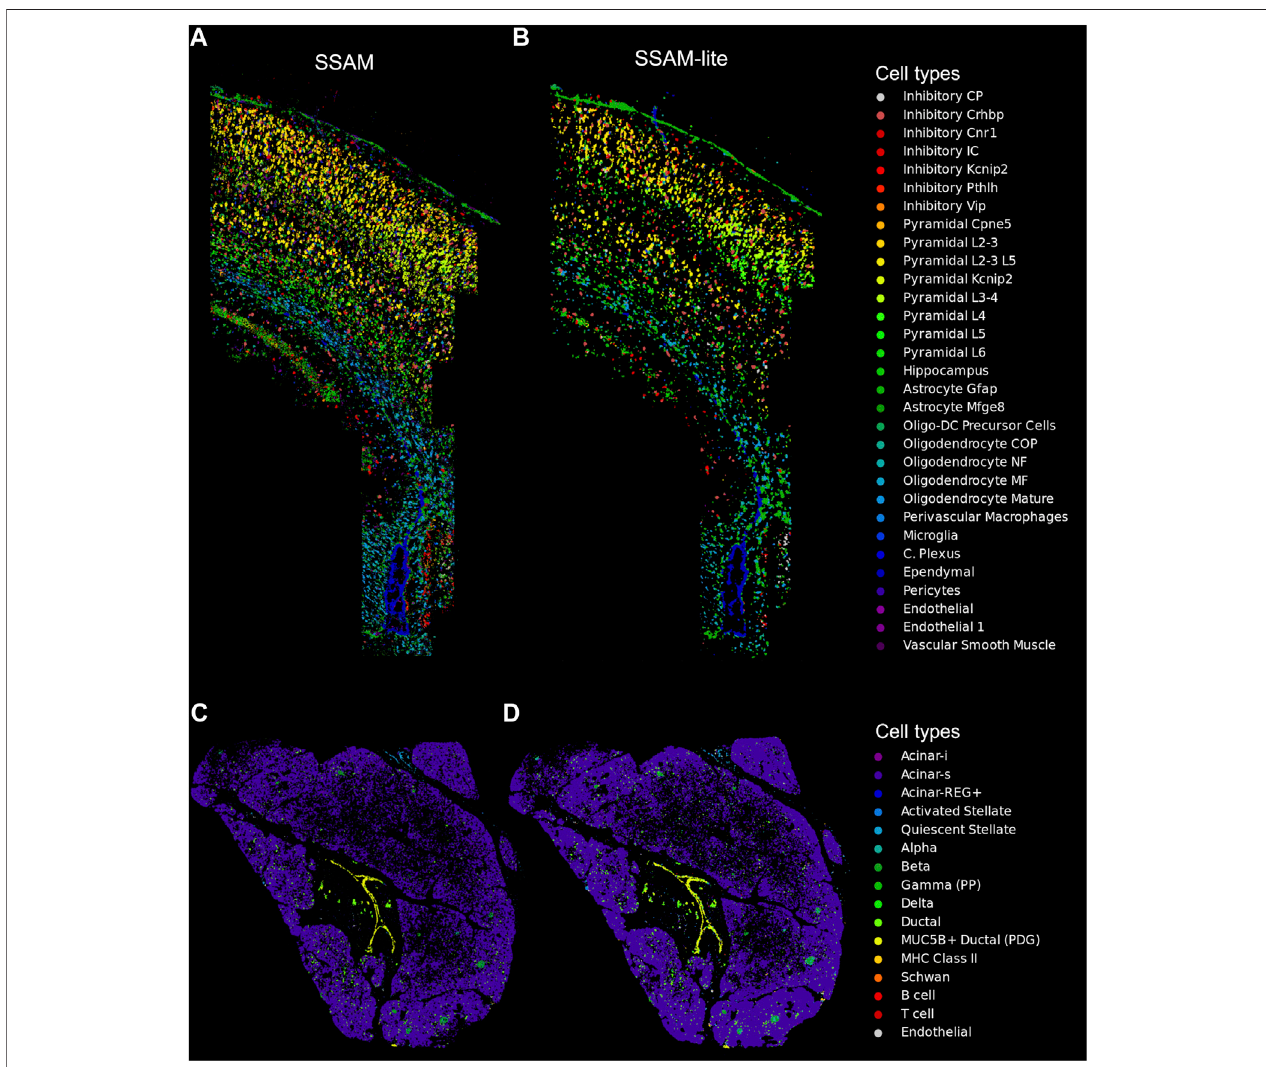
FIGURE 3 | SSAM-lite generates accurate cell-type maps. Demonstrative cell-type maps for osmFISH data of the mouse SSp generated by (A) SSAM and (B) SSAM-lite, and ISS data of human pancreas generated by (C) SSAM and (D) SSAM-lite. Resultant cell-type maps generated by SSAM are similar to previous publications (Park et al., 2021; Tosti et al., 2021). Cell-type colors of the original SSAM fi gures were modi fi ed to match the SSAM-lite fi